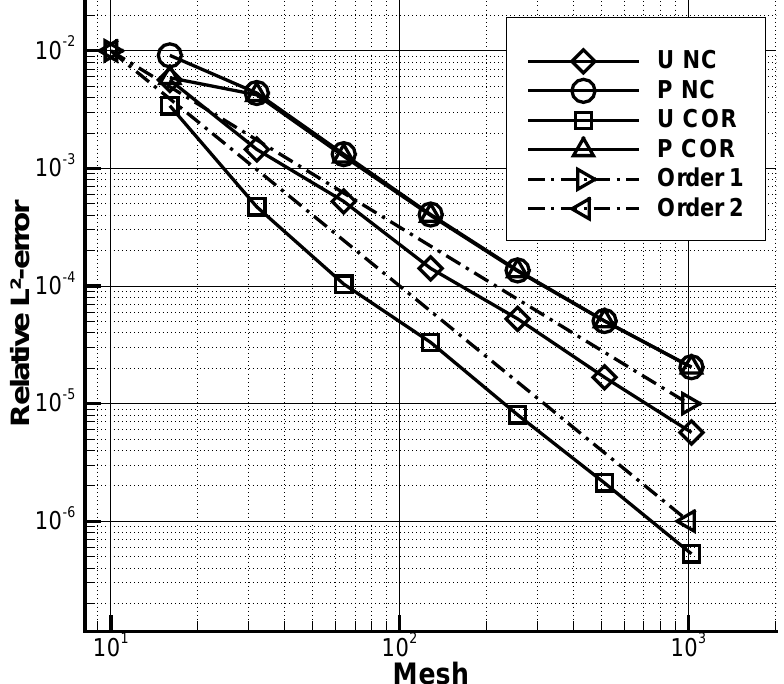
Figure 3. Evolution of the spatial error for the velocity u and the pressure p with (COR) and without (NC) the second-order correction for the Couette